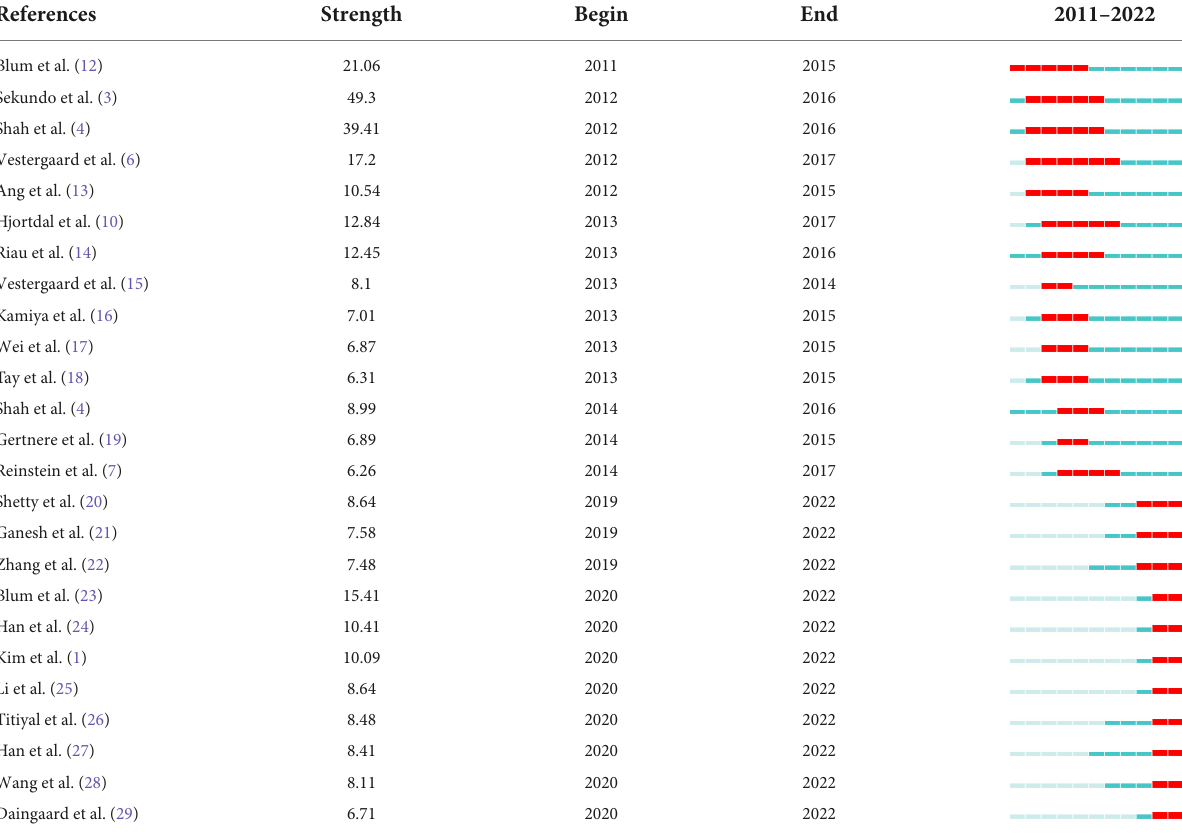
TABLE 4 The top 25 references with the strongest citation bursts in the co-citation